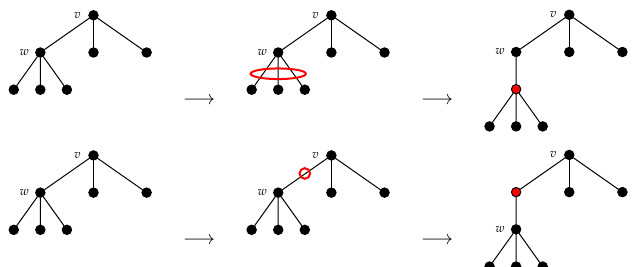
Figure 6. Adding a node as new child of w making all the current children of w children of this new node ( top ) provides the same topology as adding a new node between v and its child w ( bottom